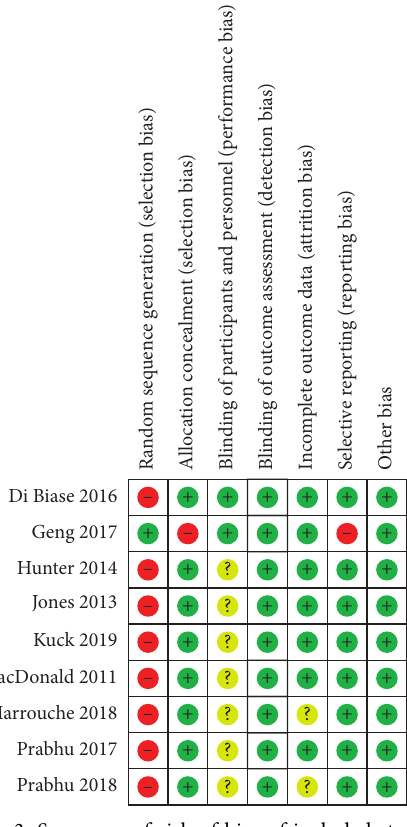
(6MWT) (MD � 28.32, 95% CI � 17.77 to 38.87; P < 0 . 0001),